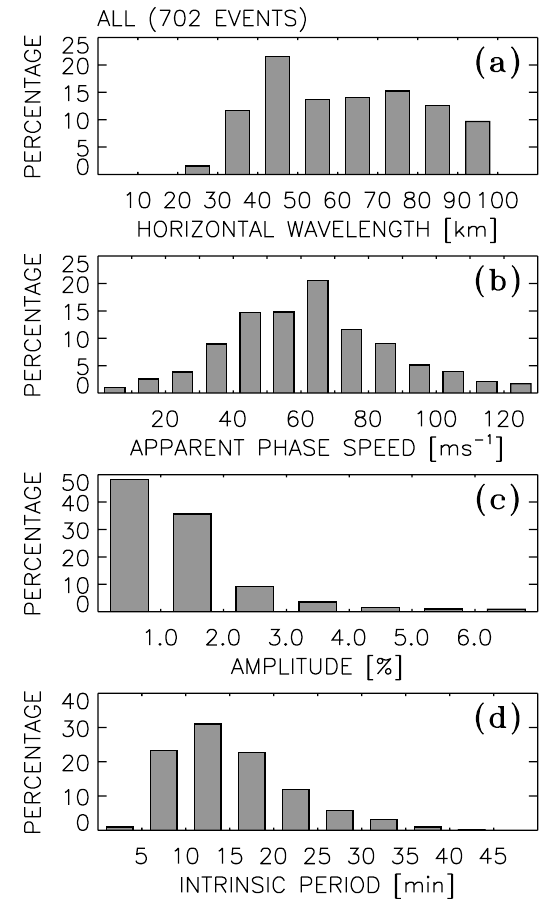
Fig. 2. Histograms of gravity wave parameters in OH airglow im- ages. (a) Horizontal wavelength, (b) apparent horizontal phase speed, (c) amplitude in airglow intensity, and (d) intrinsic wave pe-